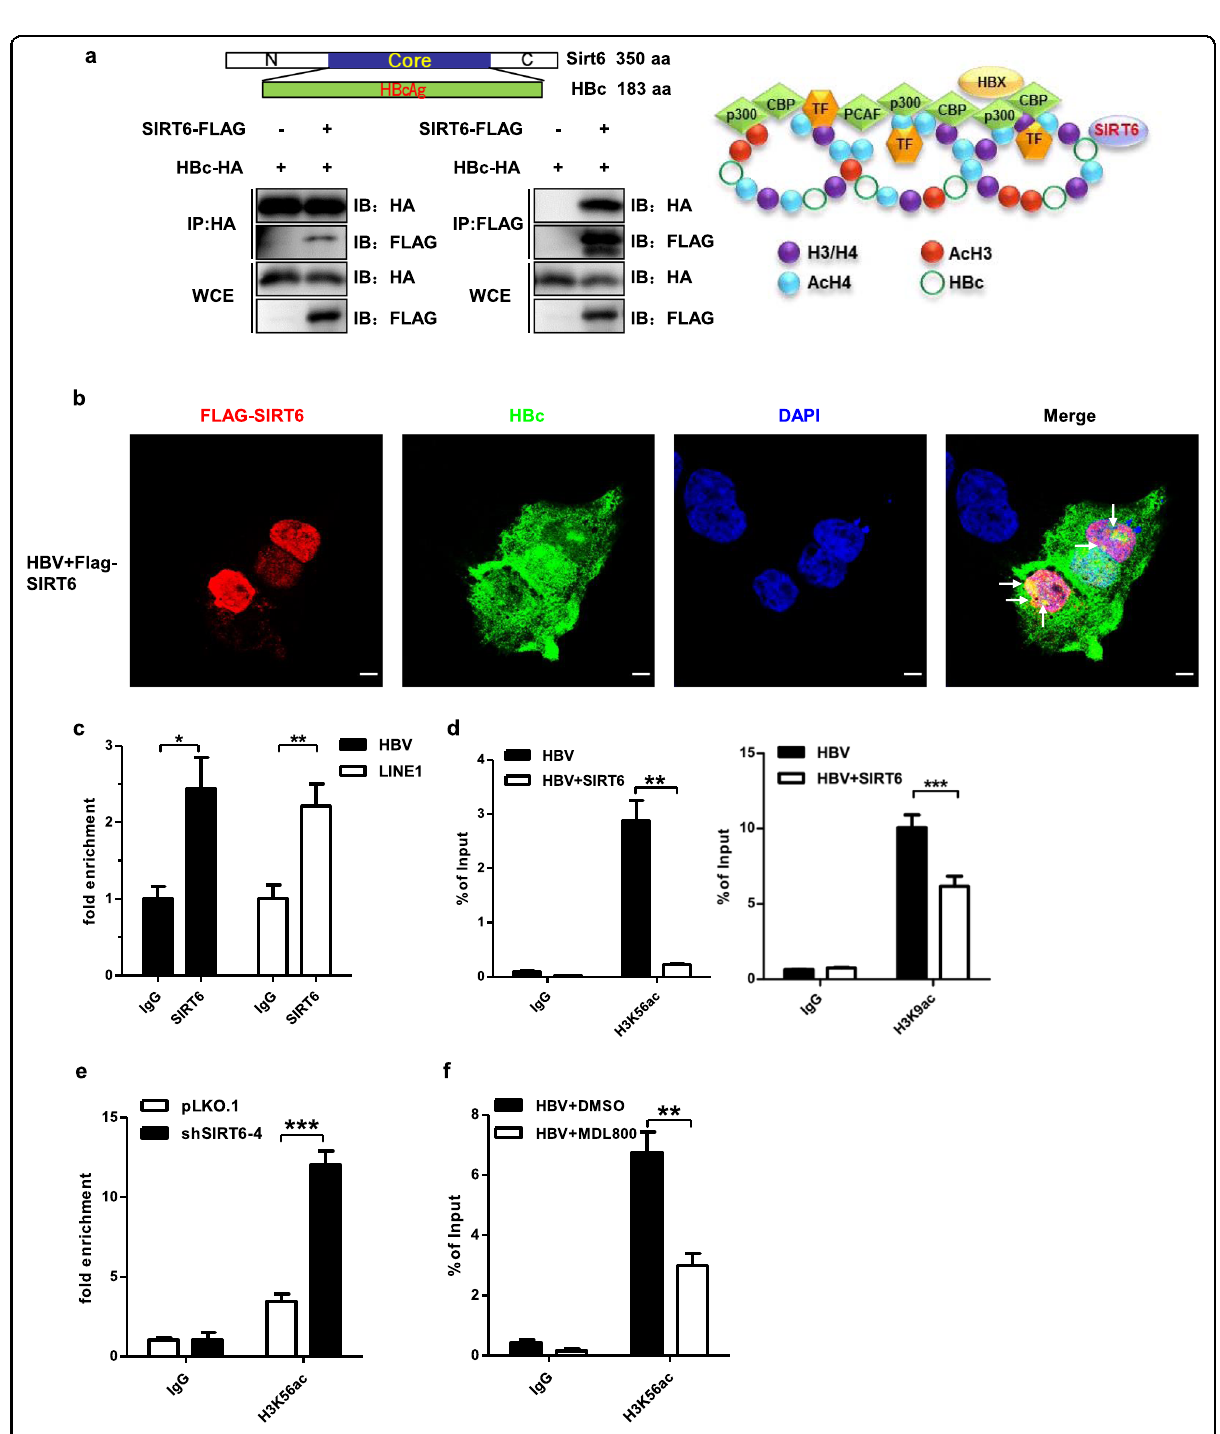
Fig. 5 SIRT6 restricts HBV gene expression through deacetylating H3K9ac and H3K56ac on HBV mini-chromosome. a SIRT6 co- immunoprecipitated with HBcAg in 293FT cells. b SIRT6 and HBcAg co-localized in the nuclei of Huh7.5.1 cells during HBV replication. Scale bars, 20 μ m. c – f ChIP assays were performed using indicated antibodies with cells upon either HBV transfection alone ( c ), or in combination with SIRT6 overexpression ( d ) or knockdown ( e ) or MDL800 treatment ( f ). * P < 0.05, ** P < 0.01, *** P < 0.001. ChIP data were acquired in Huh7.5.1 cells and were presented as bar chart ( n = 3 per